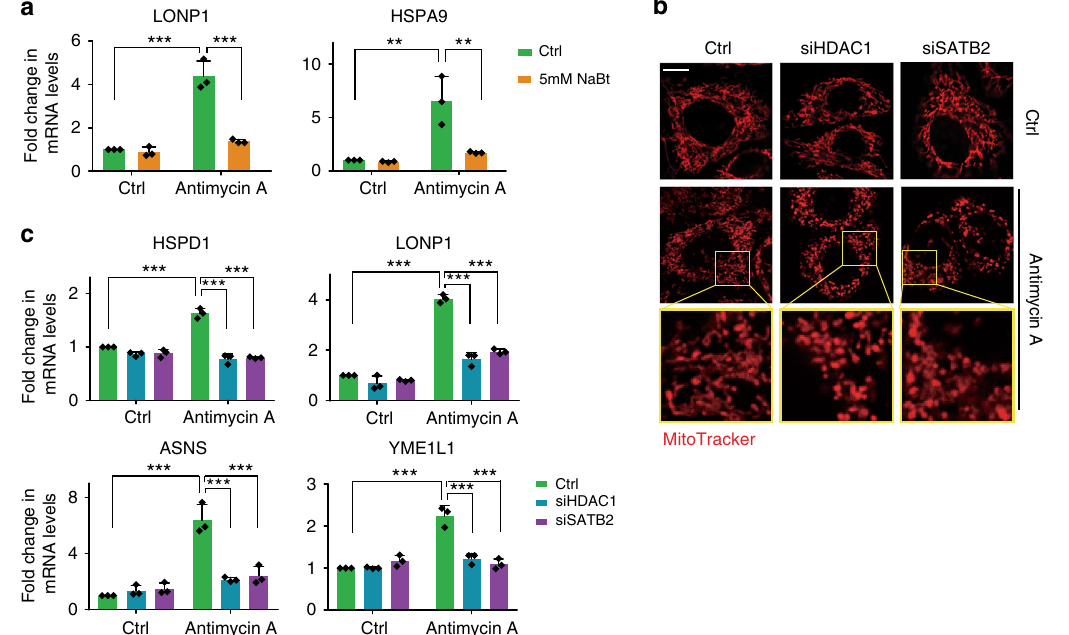
Fig. 6 The functions of HDAC1/2 and SATB2 in UPR mt activation are conserved in mammals. a qRT-PCR measures mRNA levels of LONP1 and HSPA9 in HEK293T cells cultured under indicated conditions. b Representative fl uorescence images of HeLa cells cultured under the indicated conditions. Scale bar, 10 µ m. c qRT-PCR measures mRNA levels of UPR mt genes in HEK293T cells cultured under the indicated conditions. ( a , c ) n = 3 independent experiments. Results in ( a , c ) are shown as mean + SD. P values were calculated by two-way ANOVA and Tukey ’ s multiple comparisons test (** P < 0.01; *** P < 0.001). Source data are provided as a Source Data fi